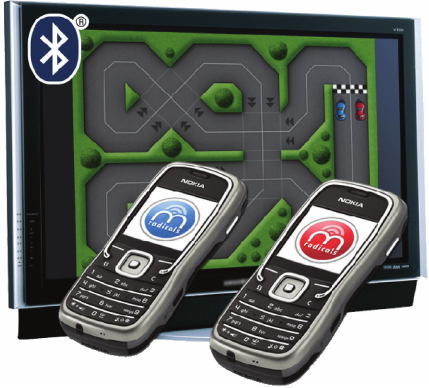
Figure 1: Poppet